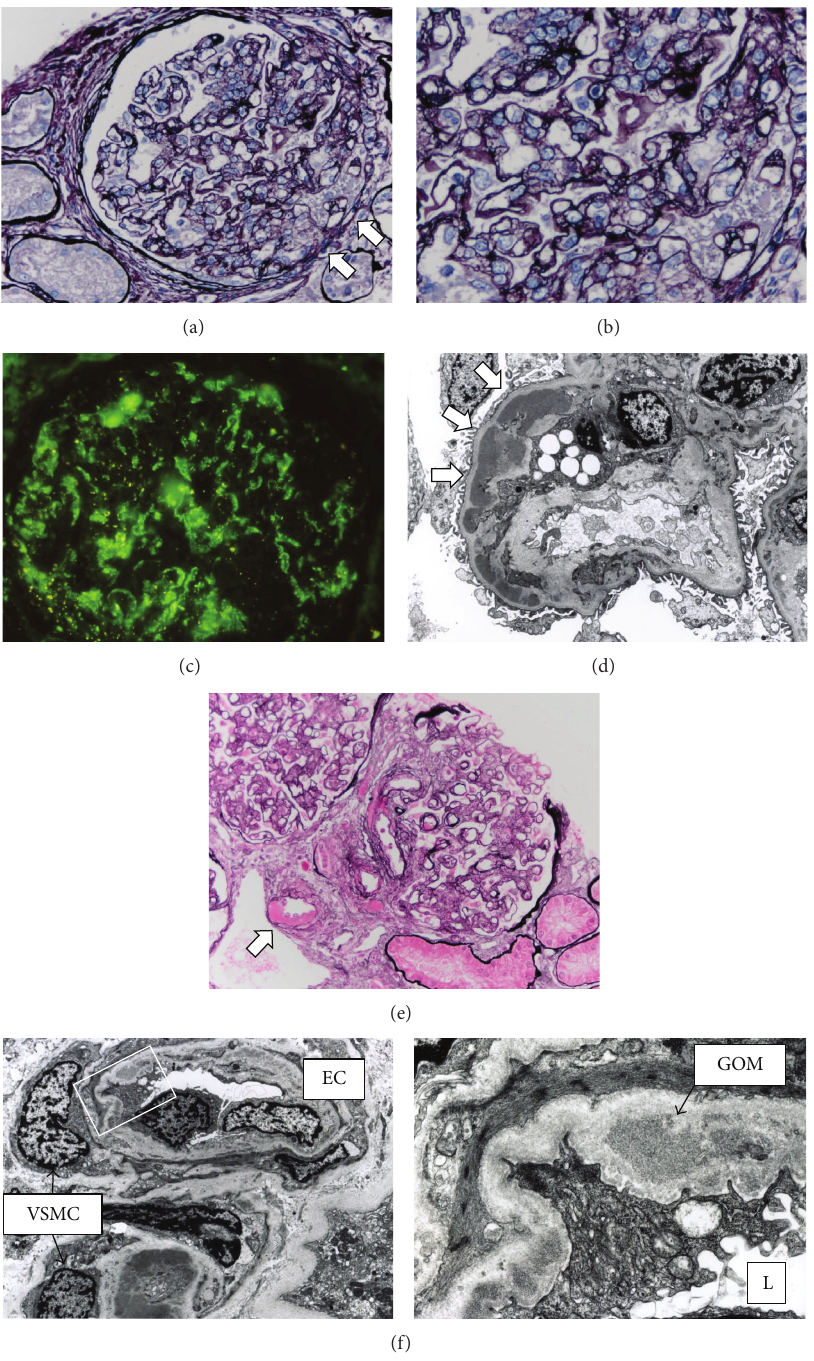
Figure 3: The light microscopic findings and electron microscopic (EM) findings suggestive of MPGN (a–d) or of CADASIL (e, f) in the renal biopsy. (a) A glomerulus showed severe mesangial expansion with mesangiolysis and segmental endocapillary proliferation. Tuft adhesion (arrow) was observed. Periodic acid-silver methenamine (PAM) stain, × 200. (b) Double contours of the glomerular basement membrane with mesangial interposition were also observed. PAM stain, × 400. (c) The glomerulus showed prominent deposition of C3 along the capillary loop. Immunofluorescence stain, × 200. (d) Dilatation of the subendothelial spaces with mesangial interposition was observed. Electron-dense deposits were also observed in subendothelial space (arrow). EM, × 2,500. (e) Severe hyaline changes of the arterioles (arrow) were observed. PAM staining, × 100. (f) Granular deposits were found in the thickened endothelial basement membrane or the basement membrane-like material of arterioles, similar to the findings of GOM. EM, × 2,500 (left panel) and × 12,000 (right panel). Abbreviations: EC: vascular endothelial cell; VSMC: vascular smooth muscle cell; L: vascular lumen; GOM: granular osmiophilic